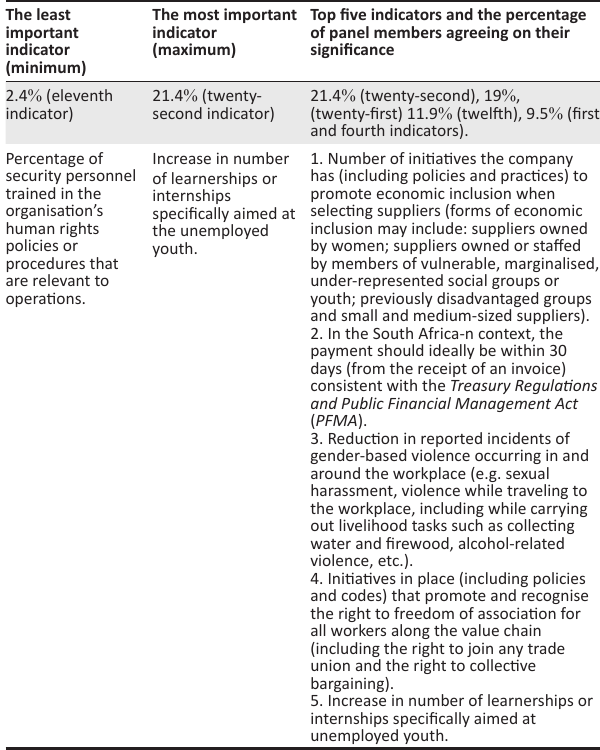
TABLE 3: Social pillar indicators from the third